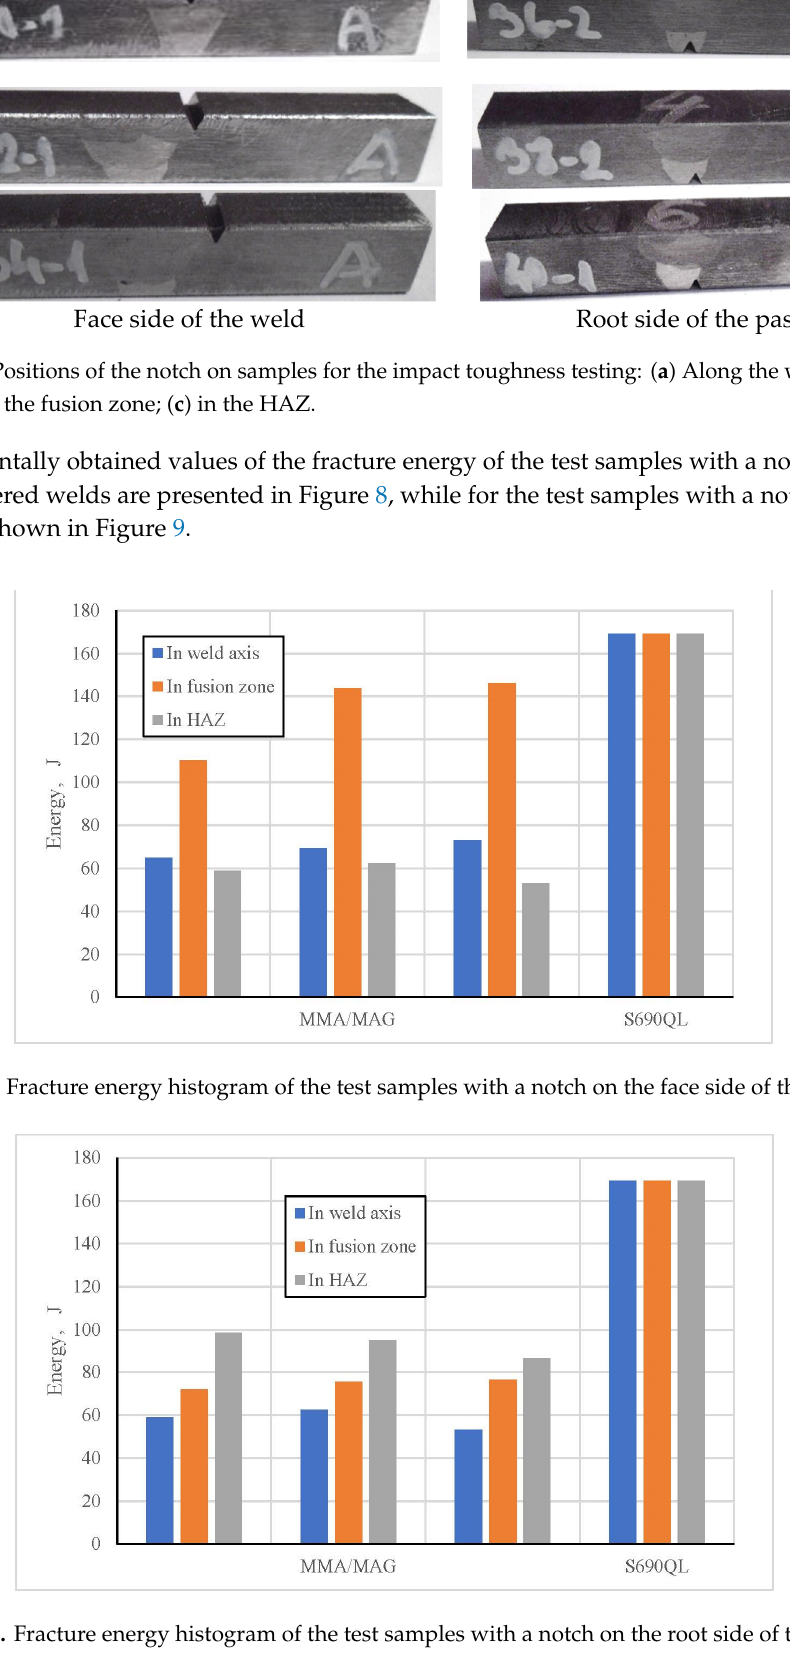
Figure 9. Fracture energy histogram of the test samples with a notch on the root side of the pass.